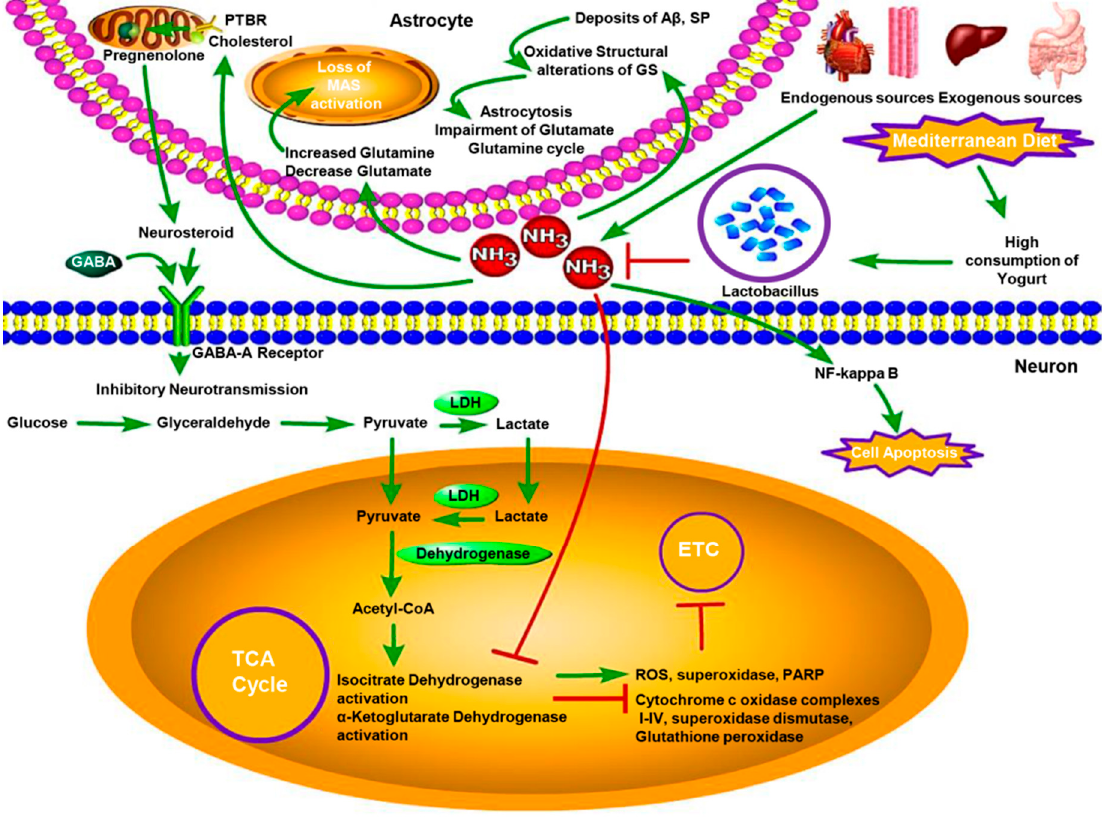
Figure 2. The neurotoxicity of hyperammonemia and protective effect of Lactobacillus in the AD brain. Blood ammonia from endogenous sources and exogenous sources crosses the blood-brain barrier and builds up in the brain regulating into increasing of glutamine, while decreasing of glutamate, which leads to the loss of malate-asparate shuttle (MAS) activity to induce the reduction of pyruvate/lactate ratio. Unrelated to MAS activity, high ammonia concentration suppresses the activities of alpha-ketoglutarate dehydrogenase and isocitiate dehydrogenase to increase the activity of ROS, superoxidase and Poly ADP-Ribose polymerase (PARP) in AD brain mitochondria. That can also decrease the activity of cytochrome c oxidase, complexes I–IV, superoxidase dismutase and glutathione peroxidase to inhibit mitochondrial electron transport chain (ETC). Hyperammonemia stimulates the PTBR localised uniquely on the astrocytic outer mitochondrial membrane inducing increased pregnenolone and cholesterol transport. The former is the precursor of “neurosteroids,” which have positive allosteric modulatory properties on the neuronal GABA-A receptor leading to increased inhibitory neurotransmission. In AD brain, the density of extracellular deposits of A β and SP in the cortex induces the oxidative structural alterations of GS by interacting with it, as well as enhances the neurotoxicity of A β . That causes loss of astrocytic GS activity and induces the impairment of Glutamate-Glutamine cycle and astrocytosis. Lactobacillus stains supresses the neurotoxicity of hyperammonemia in AD brain by reducing blood ammonia levels. LDH, lactate dehydrogenase.